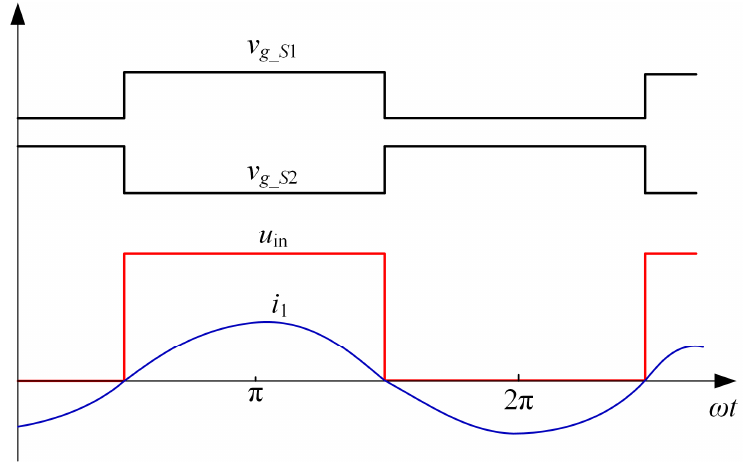
Figure 3. Implementation of the negative resistor with the characteristics of nonlinear gain saturation.